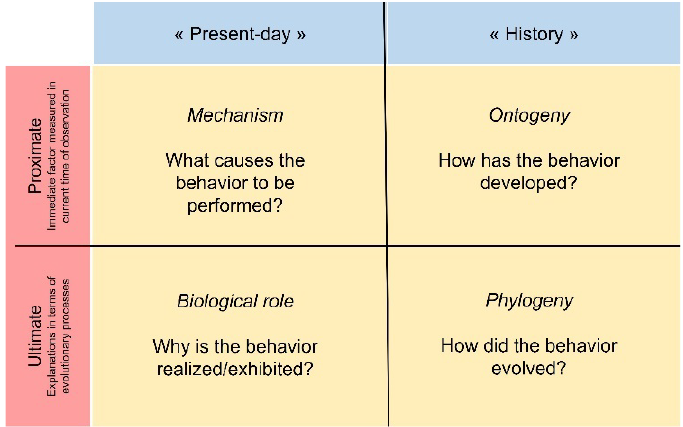
Figure 6. Classic schematic representation of Tinbergen’s four questions. Animal behaviors can be divided into movements, gestures, and postures that corre- spond to decision-making and result from motor actions [30,31]. Indeed, postures are the result of dynamic activities of the whole body or of one of its anatomical components [32]. movements and postures [33], as demonstrated in primates (Figure 7).